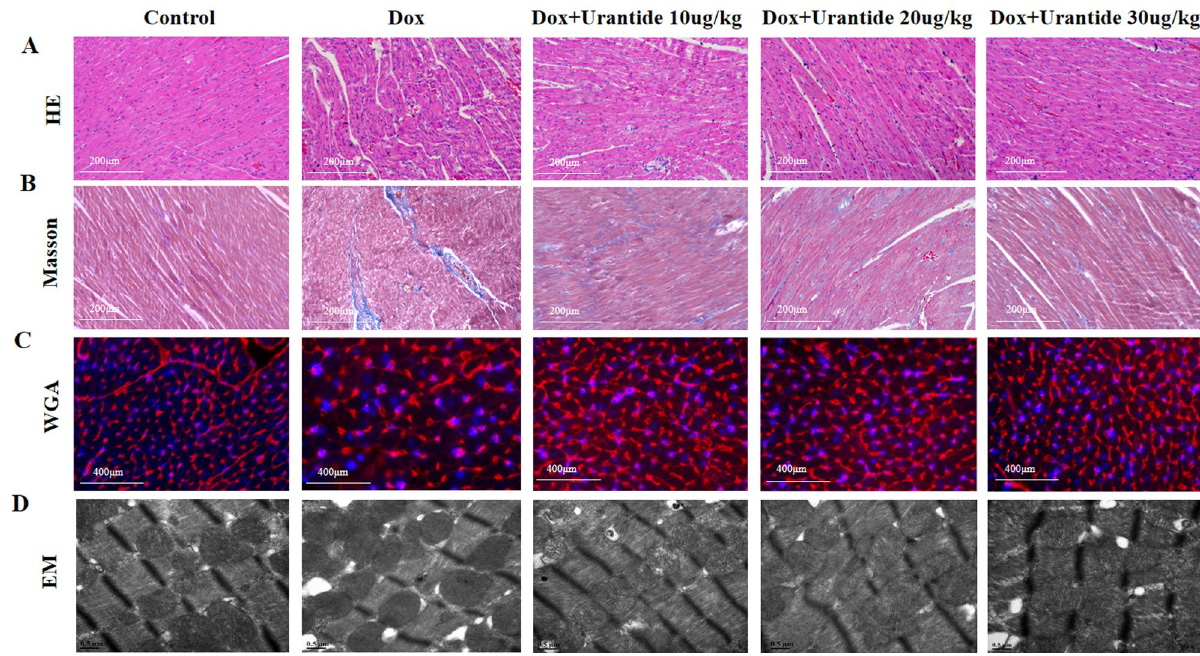
Figure 3. Urantide improves DOX-induced cardiac damage, myocardial fibrosis and cardiac myocyte hypertrophy in vivo. ( A ) HE staining of the heart tissue sections from Wistar rats treated. Bar = 200 μm. ( B ) Masson staining showing collagen content in the three Urantide treatment groups was decreased. ( C ) WGA staining of left ventricular tissue from rats for detect cardiac myocyte hypertrophy. Bar = 400 μm. ( D ) Transmission electron microscopy showing betterment of mitochondrial ultrastructure in Urantide group compared to DOX ‐ treated rats. Bar = 0.5 μm. (n =